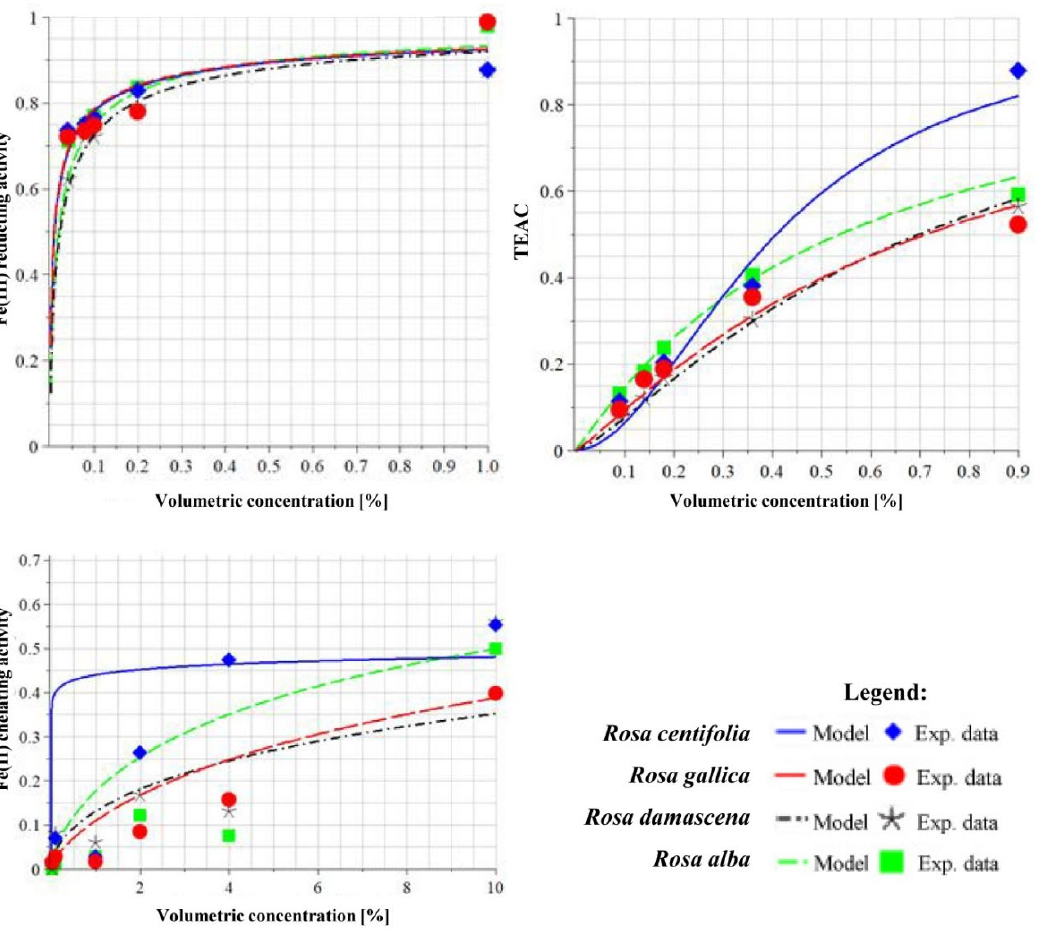
Table 5. Median effective concentration of redox-modulating capacity of wastewaters from four different rose species, determined by Cu(I)- and Fe(II)-chelating and Fe(III)-reducing activity. Redox and Chelating Activity